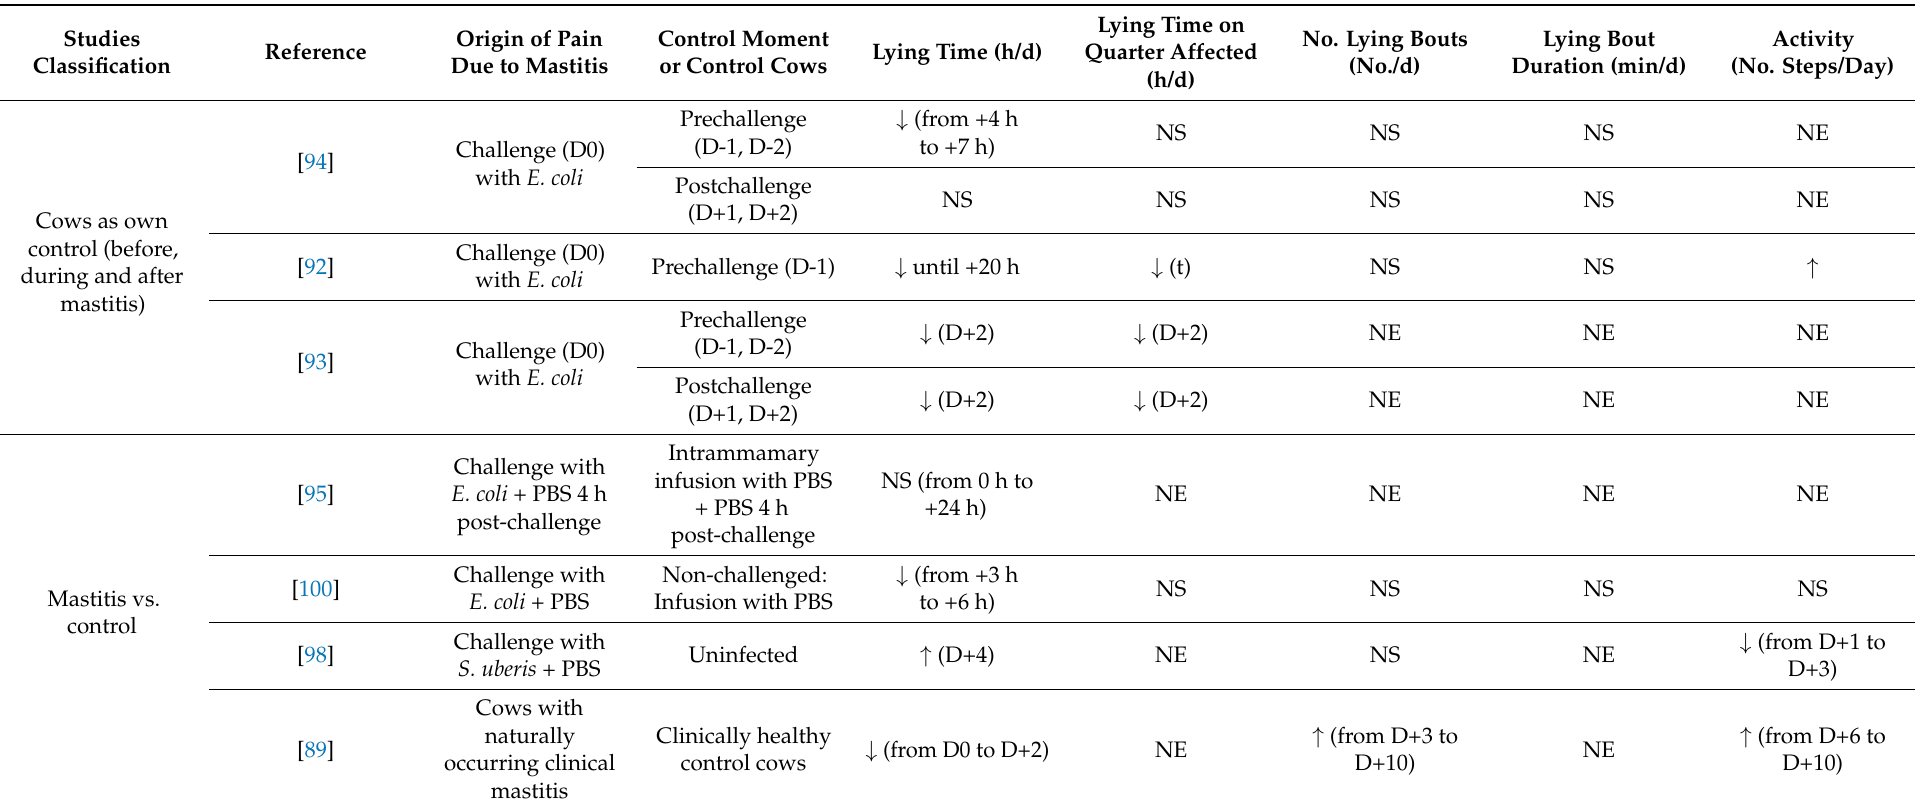
Table 1. Summary of changes in activity patterns in cows (lying time, lying time on quarter affected, number of lying bouts, lying bout duration and activity) caused by mastitis. Studies are summarized according to how they have been assessed in relation to pain using the following methods: cows studied as own control (before, during and after mastitis) and comparing cows with mastitis to the control. Moment (in days, d, or hours, h, related to challenge or naturally occurring mastitis; D0 = day of challenge or diagnosed natural mastitis) and type of change ( ↑ increase; ↓ decrease; NS = non-significant; NE = non-evaluated) are given comparing the painful moment or cows in pain due to mastitis versus the control moment or control